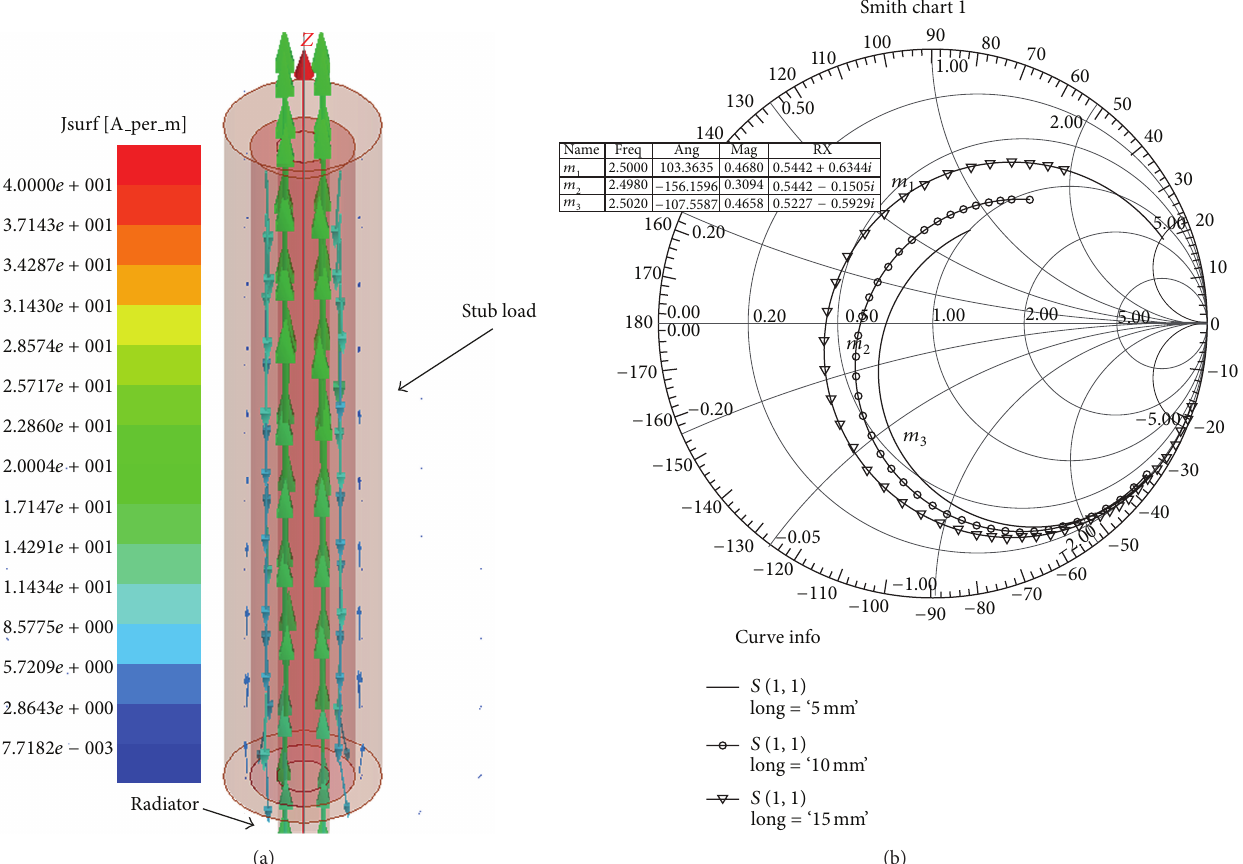
Figure 3: (a) Current distribution and (b) 𝑆 11 parameter for different stub lengths.